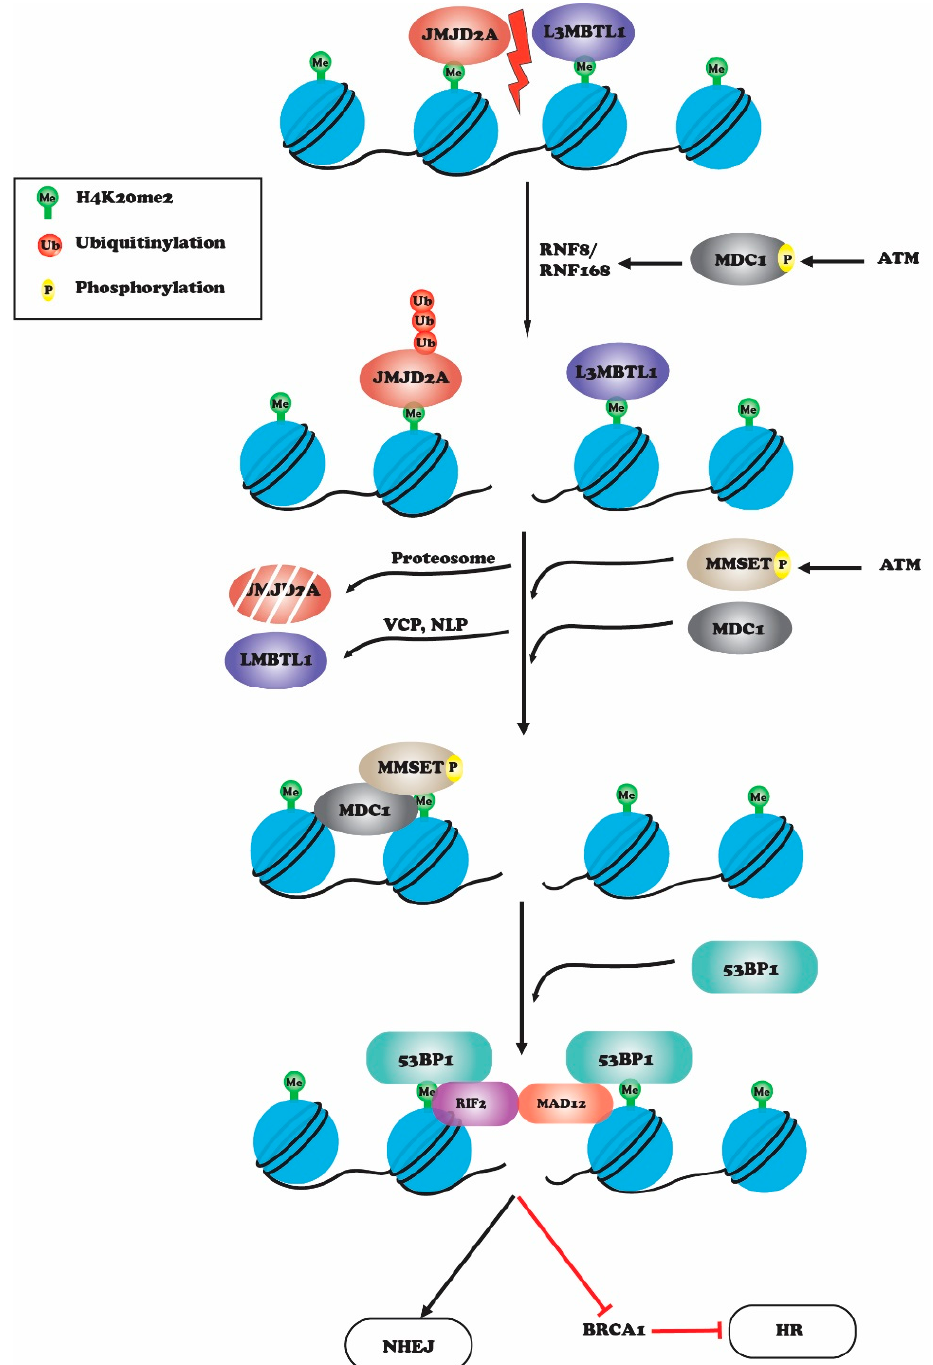
Figure 2. Upon DNA damage, L3MBTL1 and JMJD2A are released from H4K20me2 through ATM-mediated recruitment of MDC1 and phosphorylation of MDC1 at Ser 139. This leads to accumulation of RNF8 and RNF168 at DSBs, which causes ubiquitinoylation and degradation of JMJD2A by proteosome-mediated degradation and removal of L3MBTL1 by ATPase valosin-containing protein (VCP) and nuclear protein localizing cofactor protein 4 (NPL4). Thus, upon DNA damage, exposed H4K20me2 becomes available for 53BP1 binding to initiate NHEJ. 53BP1 recruits downstream effector proteins RIF1 and MAD12, which inhibit BRCA1 protein-binding to promote NHEJ over HR in the G1 phase of the cell cycle.